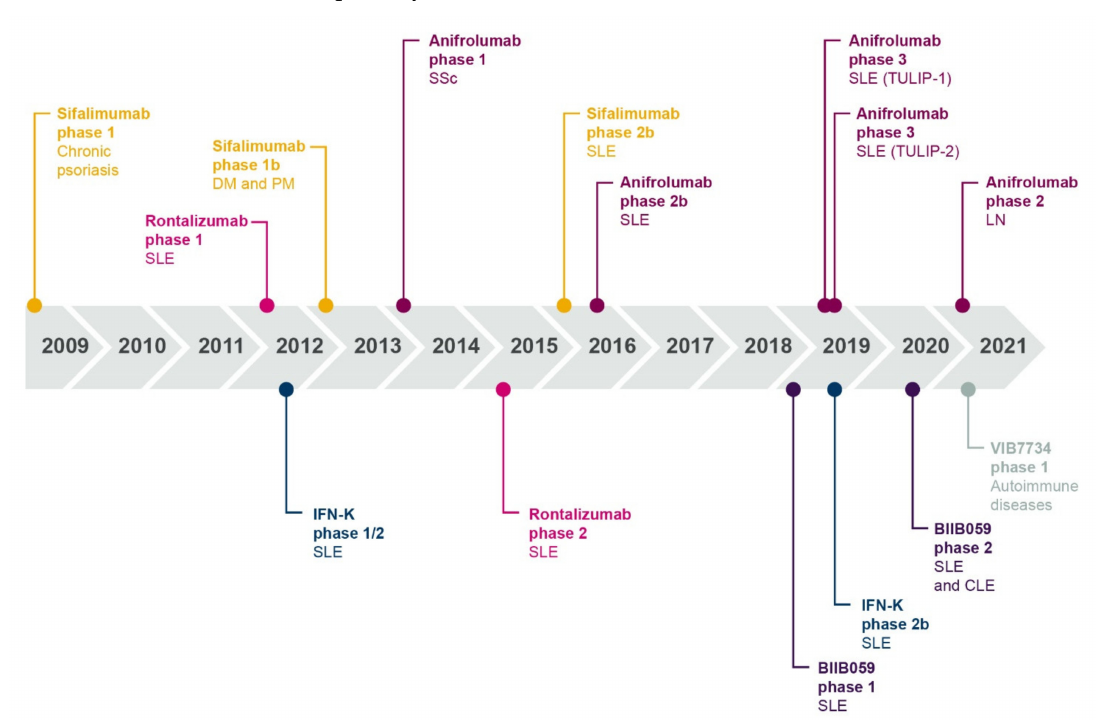
Figure 7. Timeline showing dates of publication of clinical trial data for interferon-targeting biologics in patients with autoimmune disease. CLE, cutaneous lupus erythematosus; DM, dermatomyositis; IFN, interferon; IFN-K, interferon kinoid; LN, lupus nephritis; PM, polymyositis; SSc, systemic sclerosis; SLE, systemic lupus